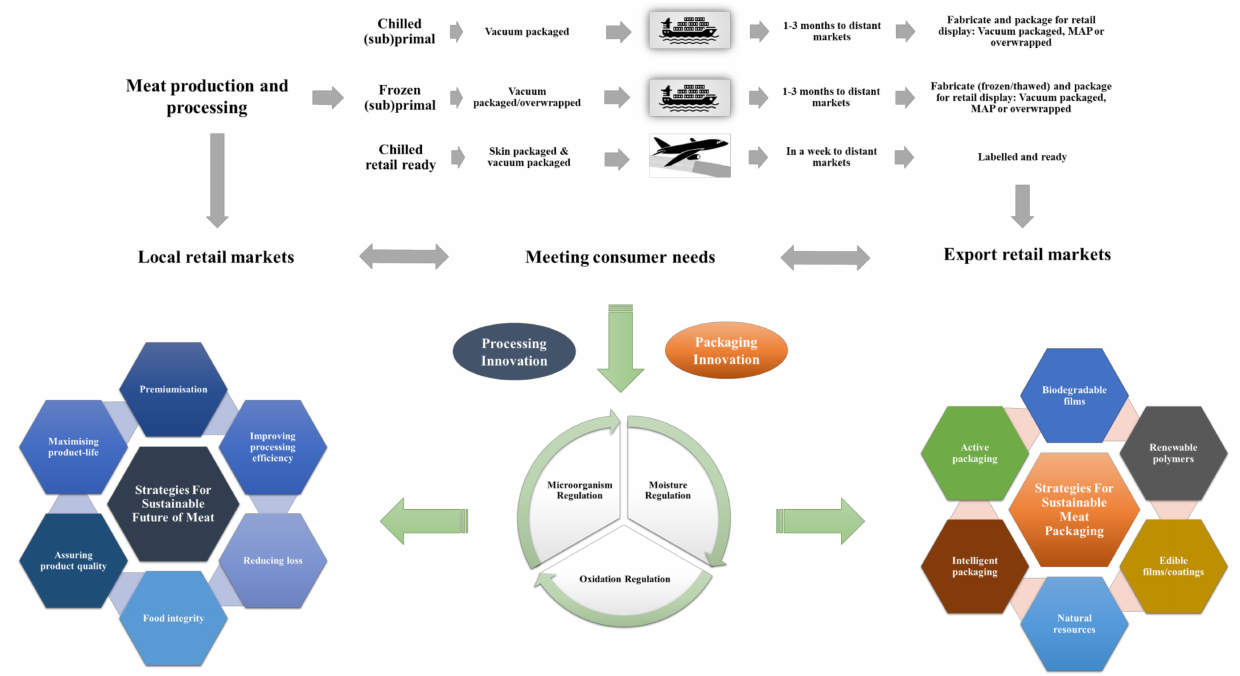
Figure 1. Example of sustainable strategies for meat processing and packaging